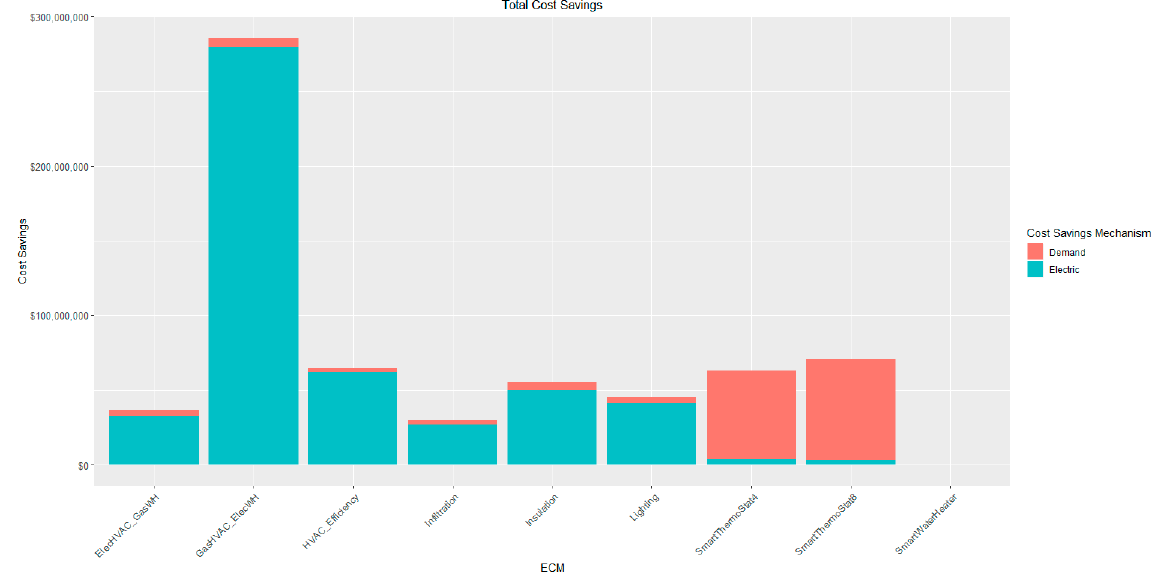
Figure 11. Combined utility-scale energy and demand annual retail-rate electricity cost savings.